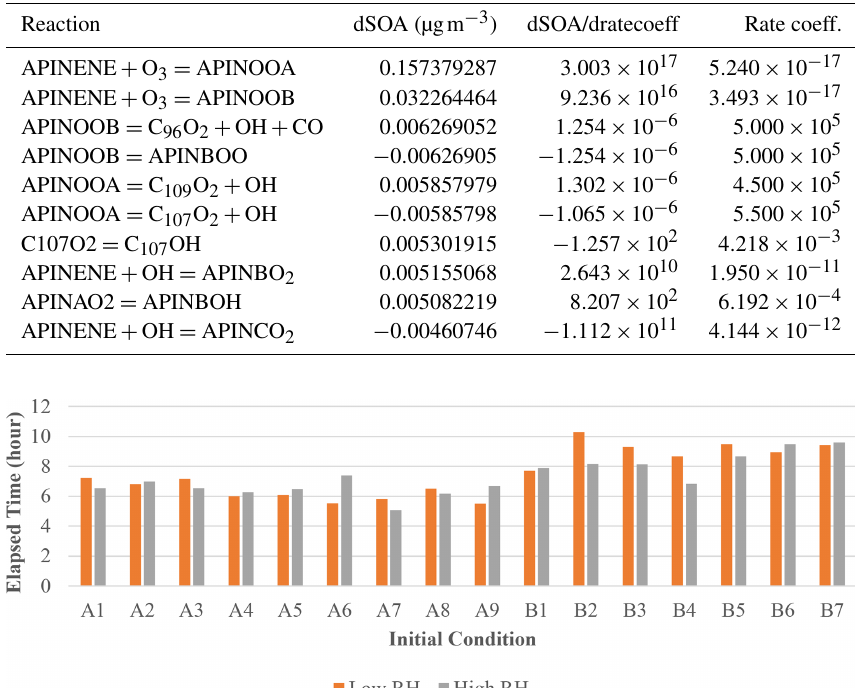
from both a programming and algorithmic sense (Table